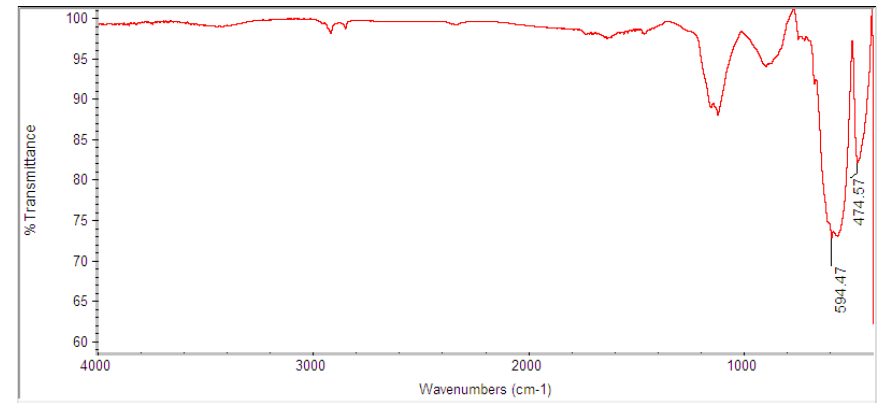
Fig. 1. FT- IR spectrum of α -Fe 2 O 3 NPs. Fig. 1. FT-IR spectrum of α-Fe